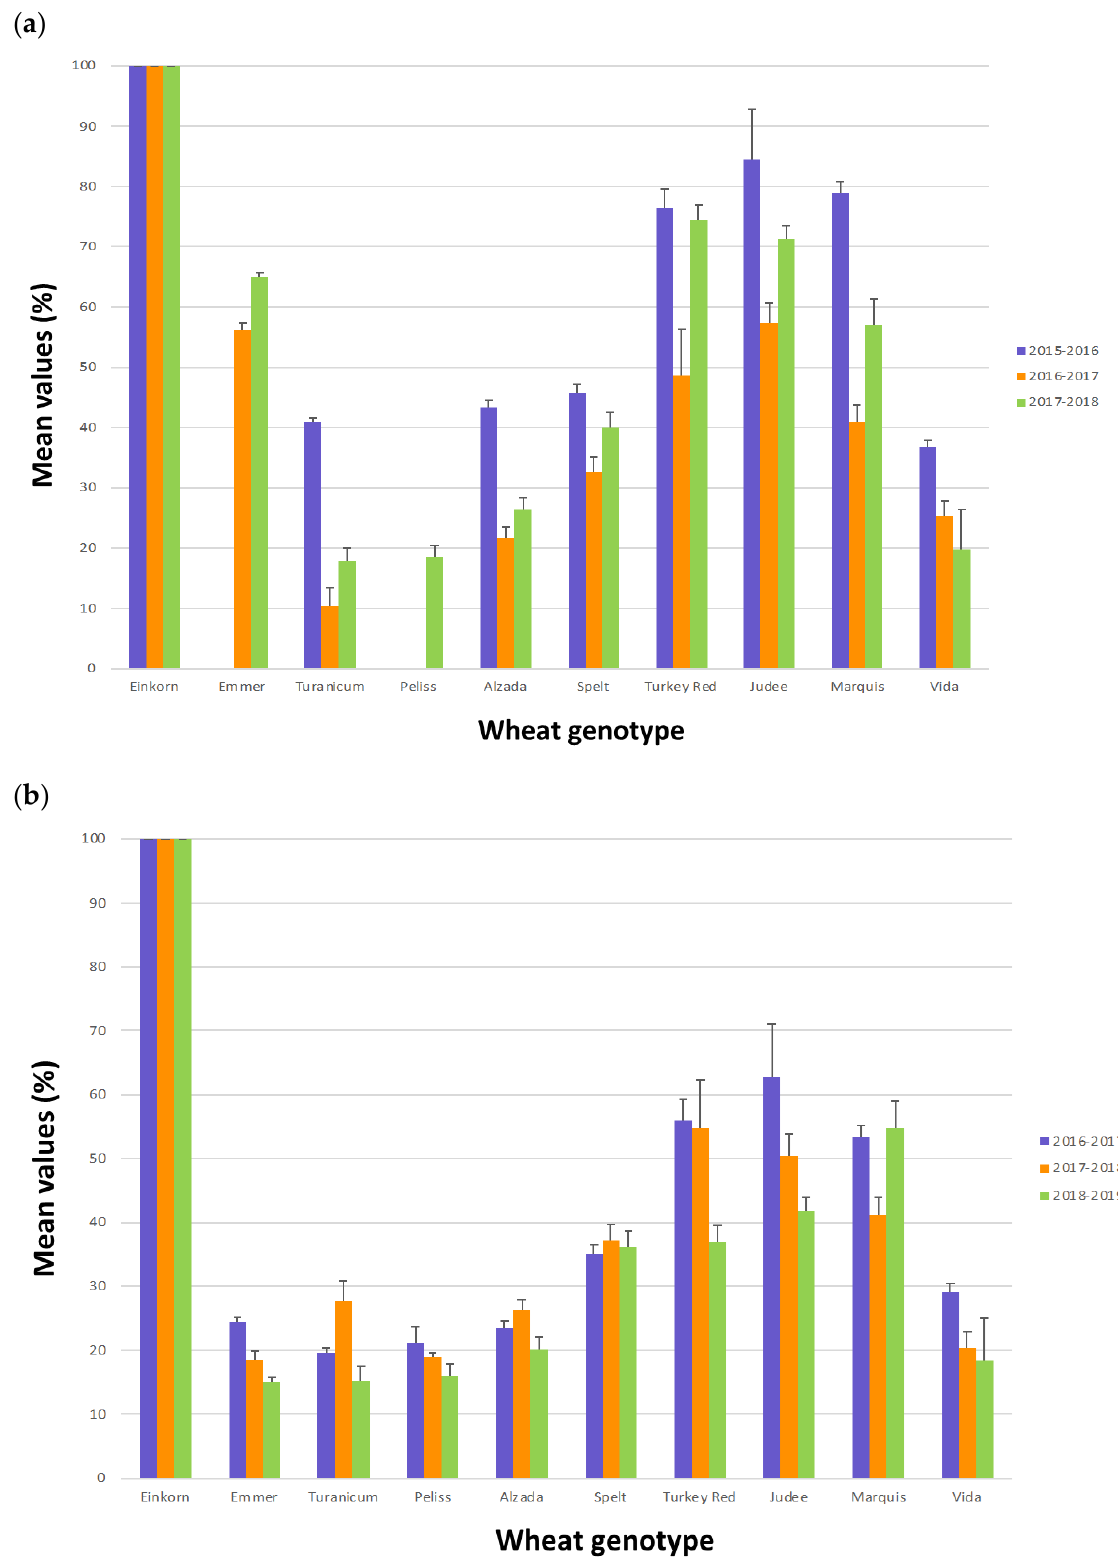
Figure 4. Mean values of the trypsin inhibitory activity for each genotype in the three crop years. Samples grown in the USA ( a ); samples grown in Italy ( b ). The bars in the graph indicate the standard error (SE).